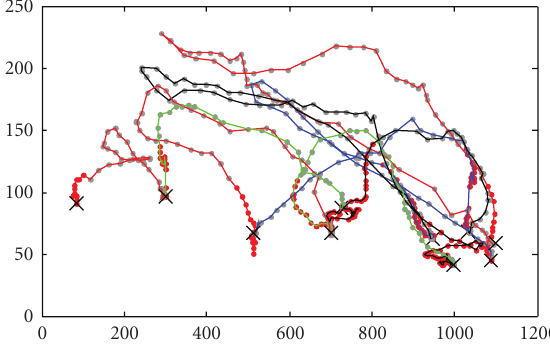
Figure 13: A search path using halo&zoom showing the height.